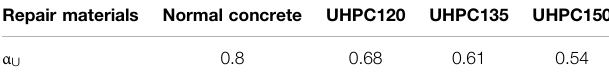
TABLE 4 | strength utilization factor of UHPC without initial stress.